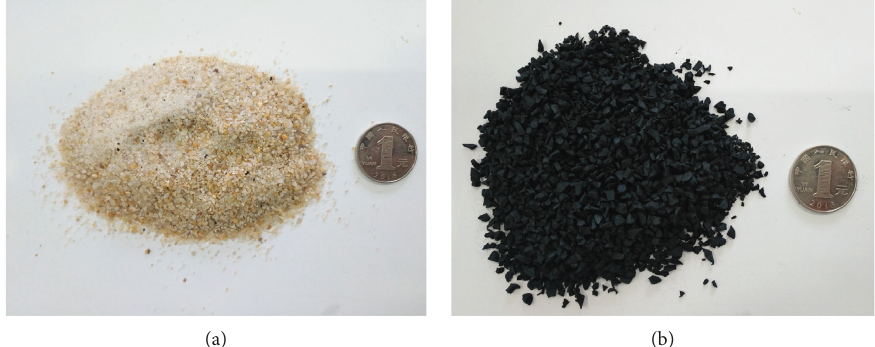
Figure 2: Materials tested. (a) Fujian sand. (b) Rubber